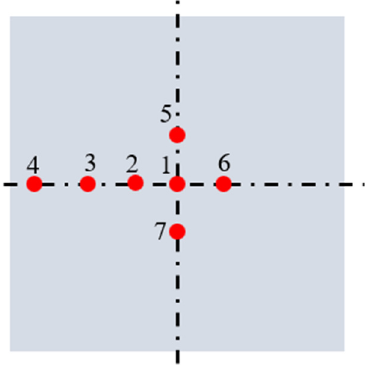
Figure 5. Selected points on the work